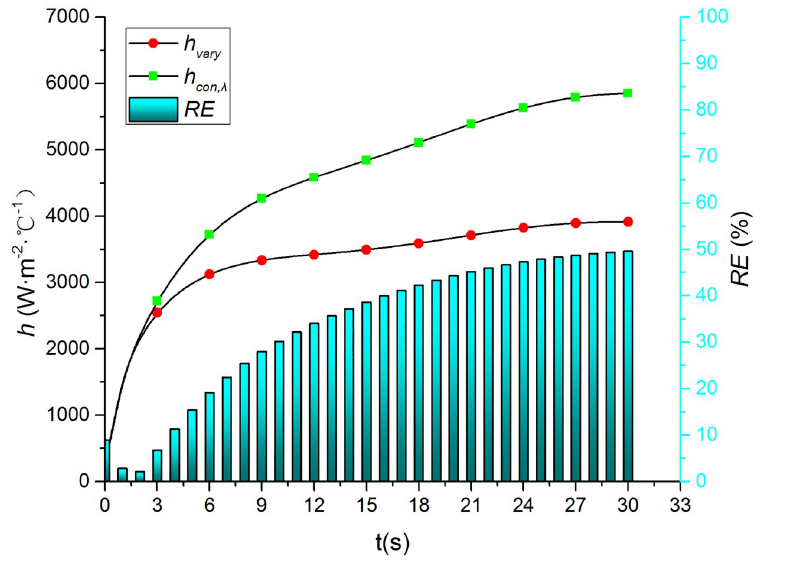
Fig 18. Comparison of h con , λ and h var y .